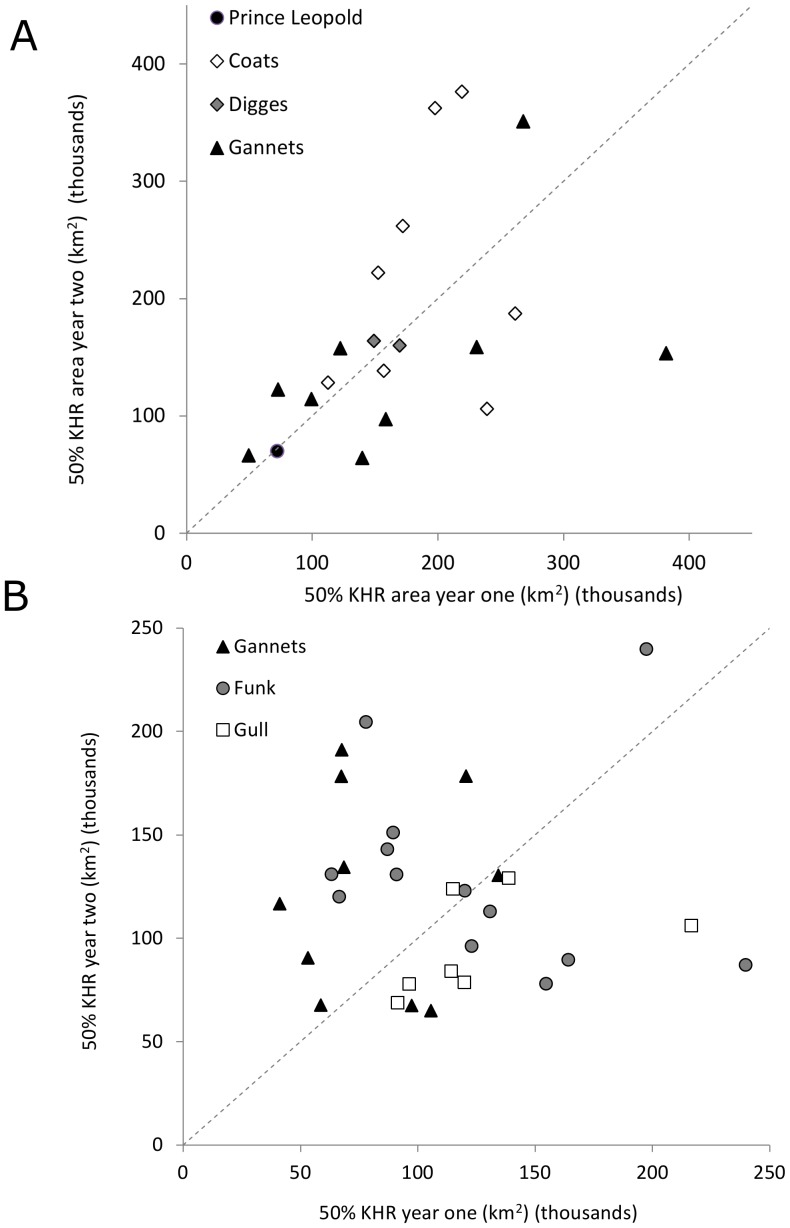
Repeated home range sizes.Relationship of 50% KHR core range sizes (km2, in thousands) in consecutive years (year one vs. year two), for (A) Thick-billed Murres and (B) Common Murres. Dotted line represents the hypothetical 1∶1 relationship if core sizes are the same in successive years.